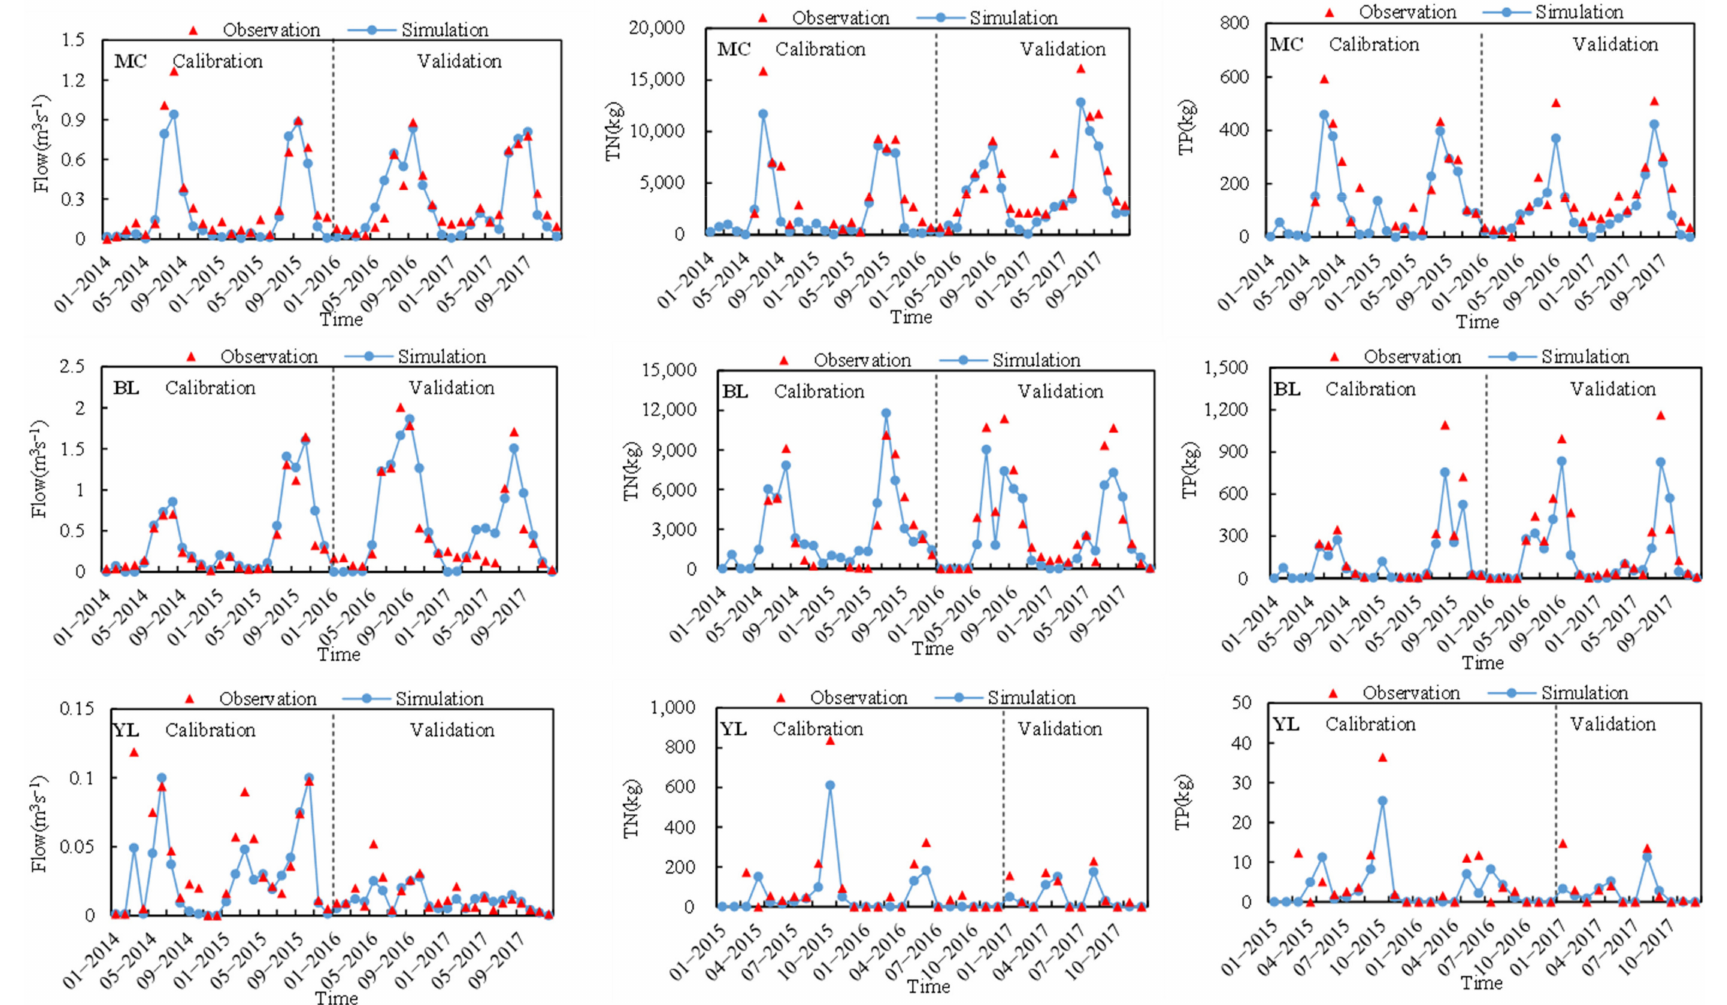
Figure 6. Calibration and validation of runoff, nitrate, and TP in typical